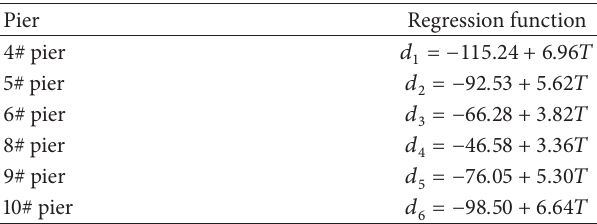
Table 3: Summary of linear regression models.